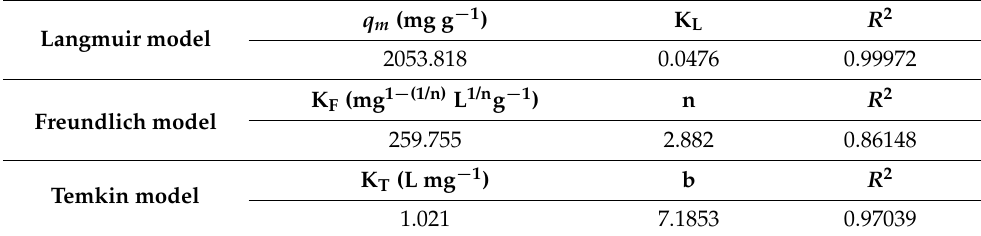
Table 12. Adsorption isotherms parameters for adsorption of CR on the HPMA